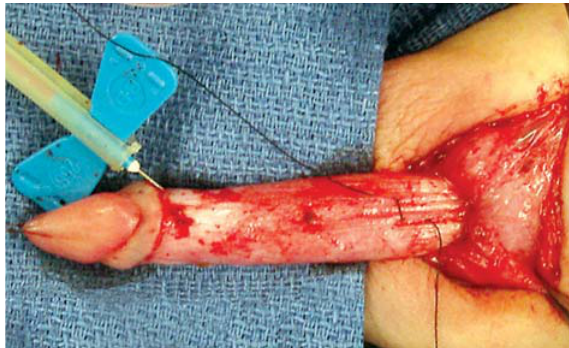
Figure 1 – Shows the diagonal corporal plication suture, which is more distal on the right corpora and more proximal on the left corpora to correct the most common direction of penile